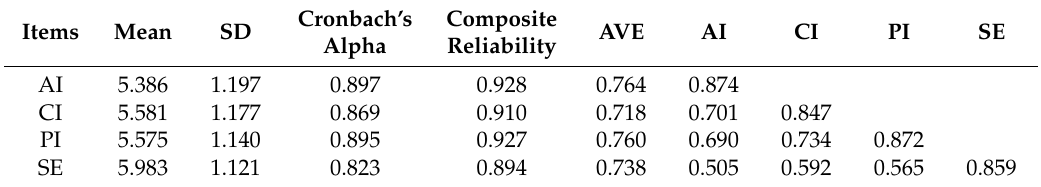
Table 3. Reliability and validity (weak ties).